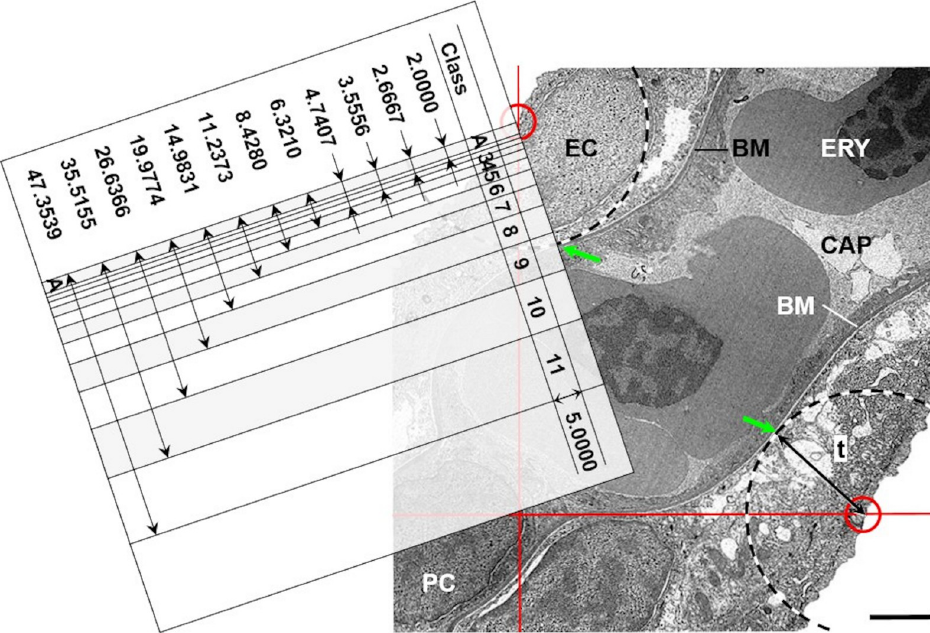
Fig 15. Determination of the true harmonic mean of the diffusion barrier thickness in secondary gill lamellae. A printed transmission electron microscopic (TEM) image of a SUR sampled field of view of an IUR section of a secondary lamella (SL) is superimposed with a test grid of lines (red). The transections of the gridlines with the epithelial SL surface are marked by red circles. At these locations, the shortest distance (t, double arrow) between the epithelial surface of the SL and the inner surface of the blood space (green arrows) is determined (dashed circles). Along these lines, the diffusion barrier thickness is measured, using a superimposed logarithmic ruler. In the shown example, the measured distance falls in class 9. T h(DB) is calculated from the number of measurements and the corresponding classes ( Eq 13 ), detailed illustration is given in Hirose et al. [115]. Epon. TEM. Bar = 2 μ m.